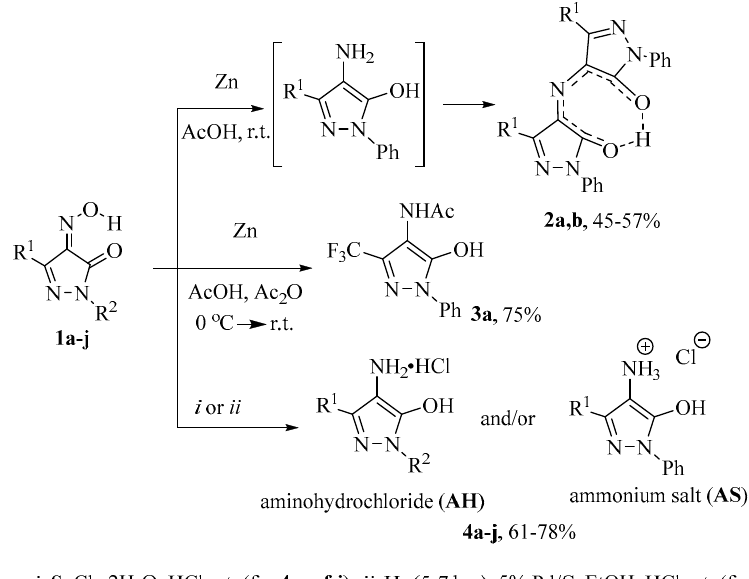
Scheme 1. Reduction of 4-hydroxyiminopyrazolones 1a – j